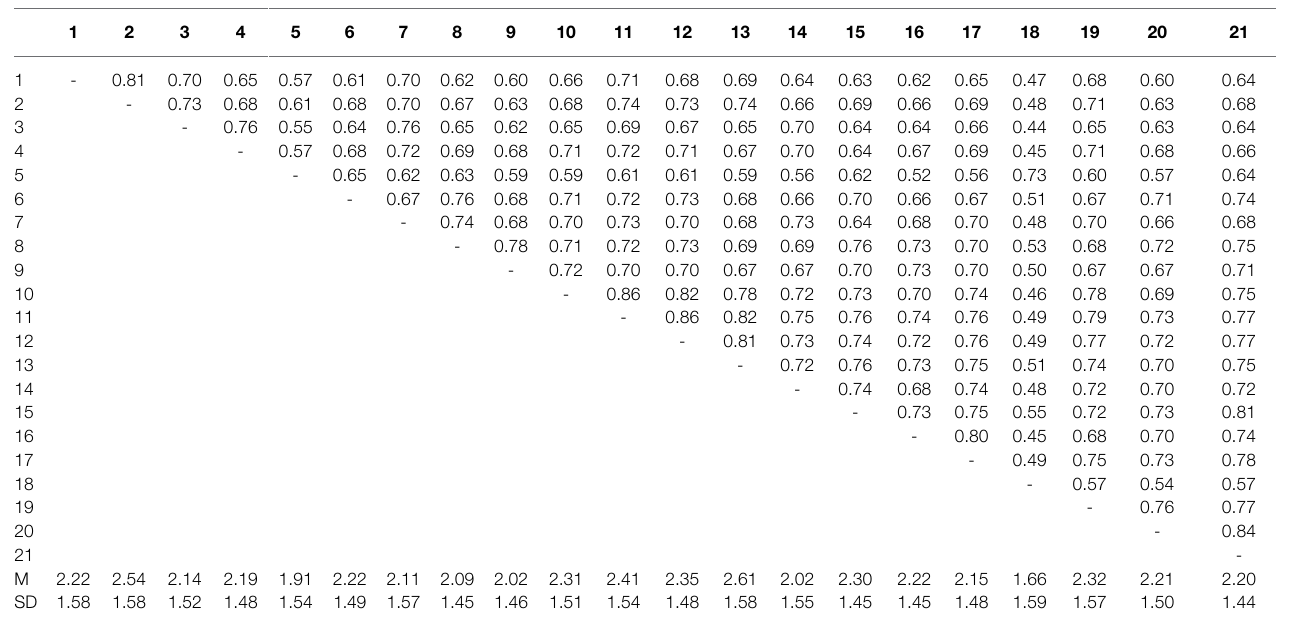
TABLE 3 | Correlation matrix and means and standard deviations of the PTGI items.